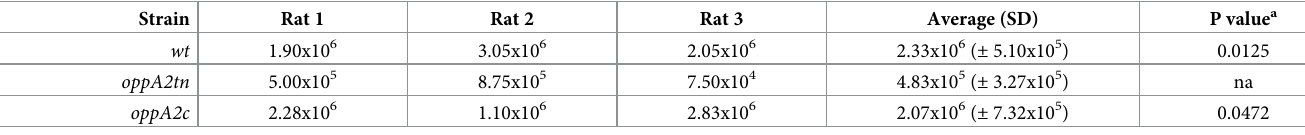
serology four weeks later. In contrast to oppA1tn (Table 1), oppA2tn spirochetes were recov- ered only from the inoculation site (Table 2 –Pilot Experiment 1), and oppA2tn -infected mice displayed minimal serological response (S3A Fig). Complementation restored infectivity and serological responses, albeit with less robust serologies than wt (S3B Fig and Table 2 –Pilot Experiment 2), confirming this distinctive phenotype was due to loss of oppA2 . Spirochete burdens in the inoculation sites were equivalent for all strains as assessed by qPCR (S3C Fig); furthermore, for all three strains, cultures from inoculation sites were darkfield-positive within the same time frame (one week). The oppA2tn mutant did not display a growth phenotype in vitro (S1B Fig) but was recovered from dialysis membrane chambers (DMCs) at ~ 4-fold lower mean final density than wt and oppA2c ; this difference, while modest, was statistically signifi- cant (Table 3). Even so, DMC-cultivated oppA2tn host-adapted normally (i.e., downregulated OspA and upregulated OspC; S3D Fig). We next devised a protocol to assess the ability of the oppA2tn mutant to disseminate by the hematogenous and intracutaneous routes. To assess hematogenous dissemination, we cultured blood, daily, five to seven days post-inoculation, the period of peak spirochetemia [44], and organs harvested at the time of sacrifice (4 weeks). To evaluate cutaneous spread, we cultured skin from thirty-two sites (including inoculation site and pinnae) evenly distributed across the dorsa and ventra (Fig 3A–3C). Blood (Table 4) and distal tissues from oppA2tn- infected mice Table 3. oppA2tn densities from DMCs (spirochetes/ml).